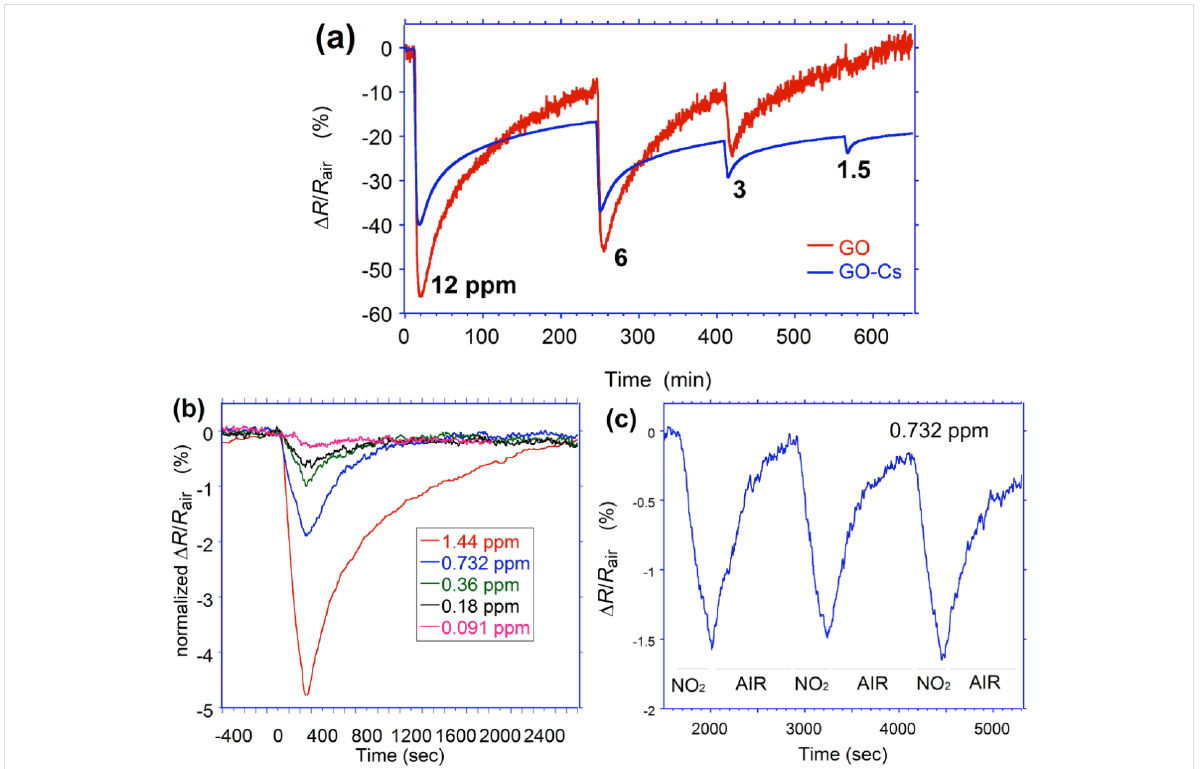
Figure 6: Response of (a) GO-Cs and GO based sensors towards NO 2 with concentrations higher than 1 ppm; (b) GO-Cs based gas sensor after exposure to different concentrations of NO 2 ranging from 0.091 to 1.44 ppm and (c) GO-Cs based sensor during 3 successive cycles of exposure to 0.732 ppm NO 2 for 4 min and to dry air for 15